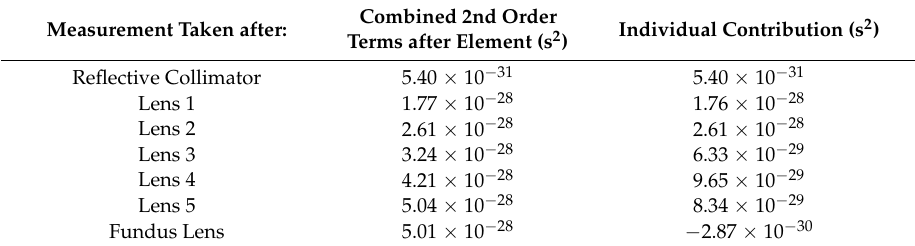
Table 1. Contribution of each lens (summed and individual) to the dispersion mismatch. Measurement Taken